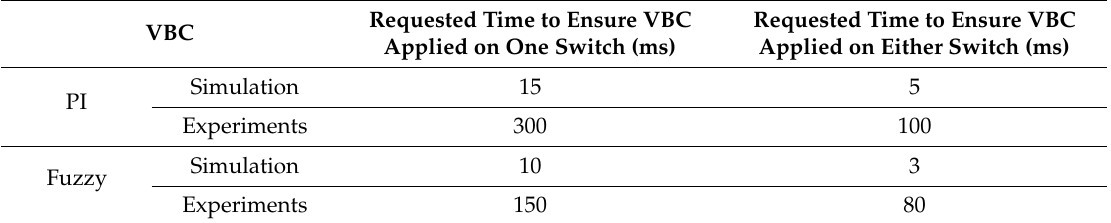
Table 3. Time to ensure